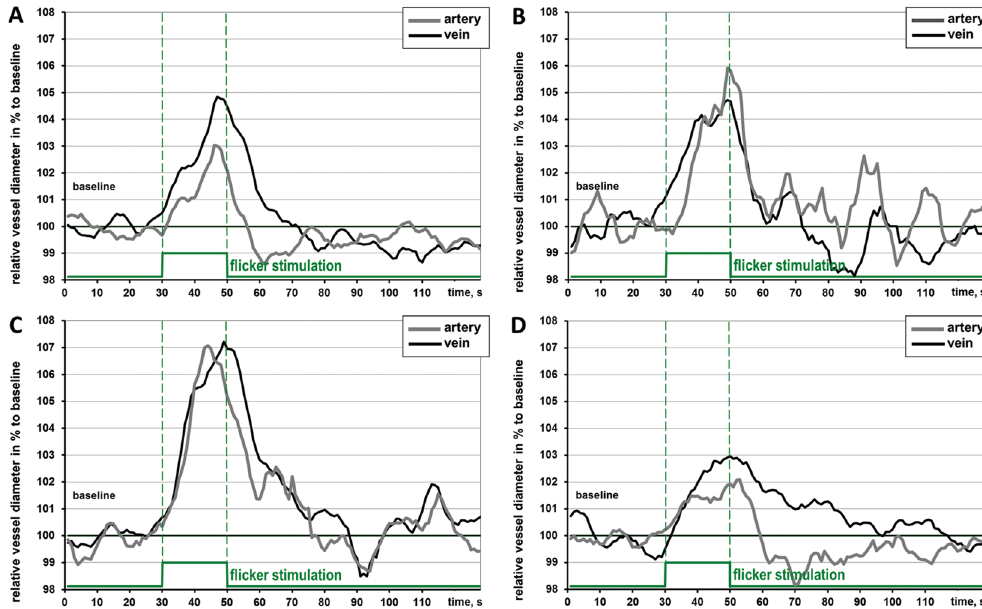
Figure 2. Characteristic examples of individual smoothed averaged retinal arterial and venous reactions to flickering light: ( A) healthy control; ( B ) MCI-nonAD; ( C ) ADD; ( D ) MCI-AD.